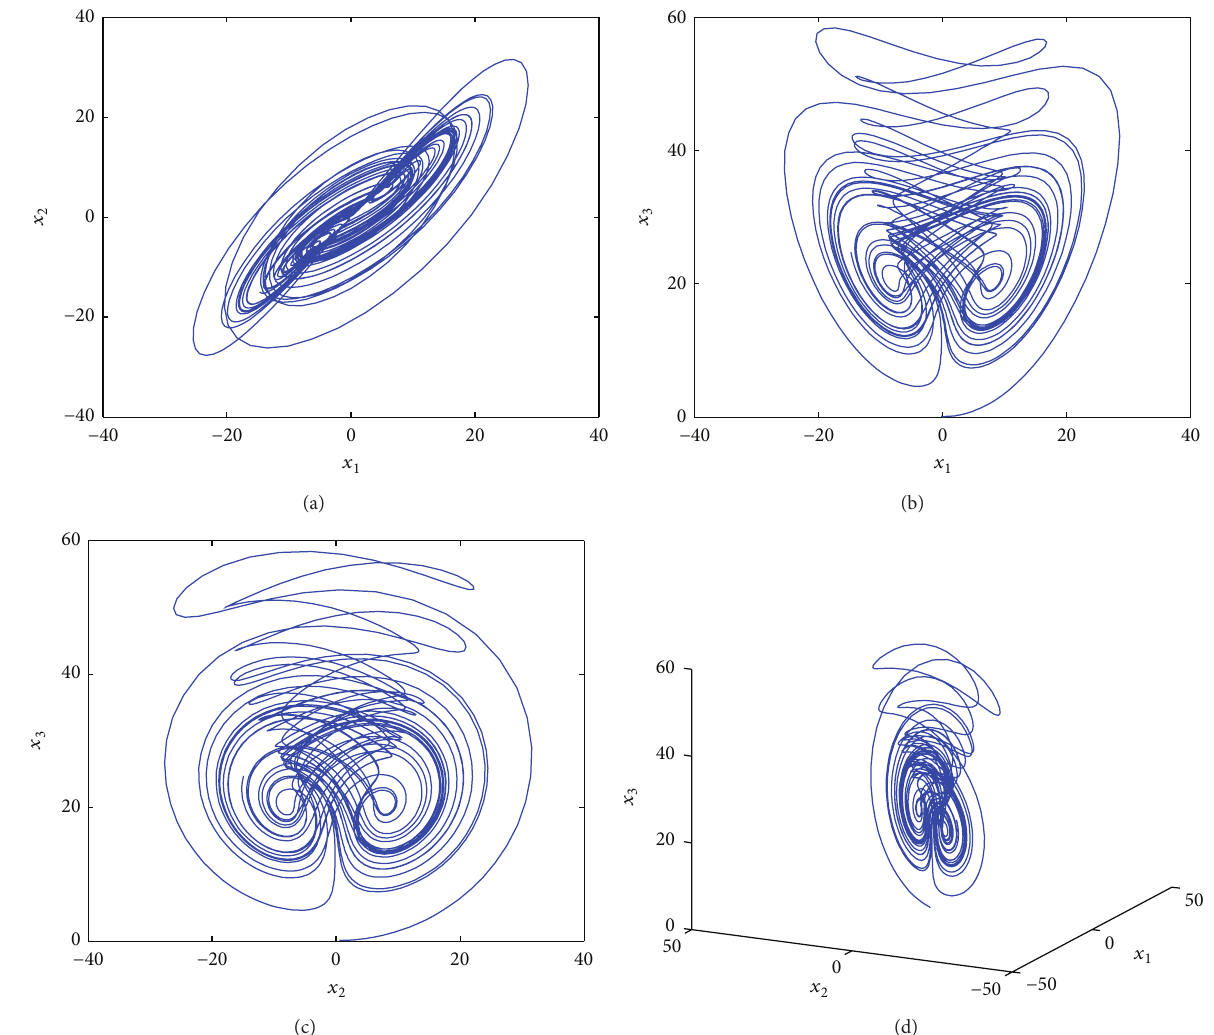
Figure 5: Chaotic attractors in the fractional order L¨u system with 𝛼 = 1.09 . The panels (a), (b), (c), and (d) show the 𝑥 2 −𝑥 1 , 𝑥 3 −𝑥 1 , 𝑥 3 −𝑥 2 , and 3D views,